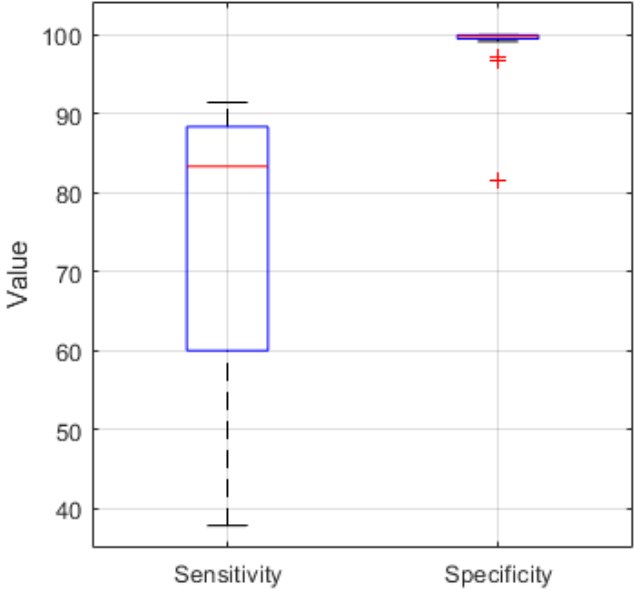
Figure 8. Sensitivity and Specificity boxplot (median value (red), lower and upper quartile (blue), min. and max. value (black), outlier (red cross)) for 21 EEG recordings classified in MATLAB with a median of 83.3% and 99.8%,